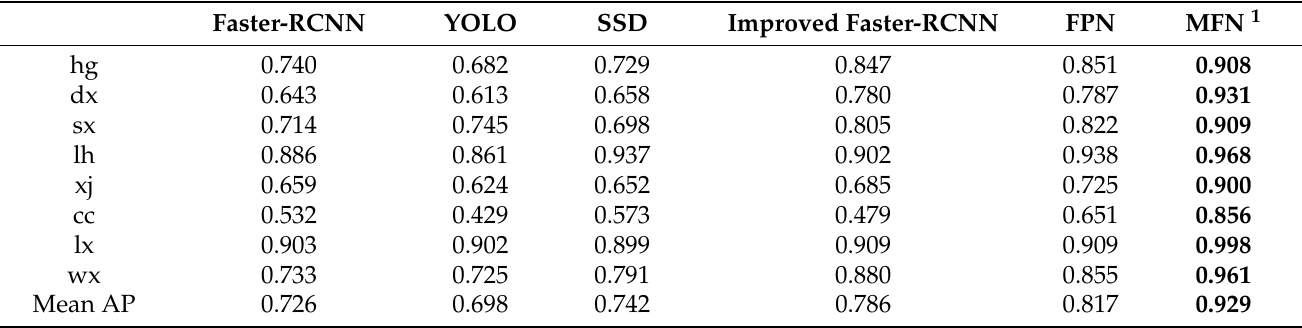
Table 3. APs and mAPs of different methods in the ablation